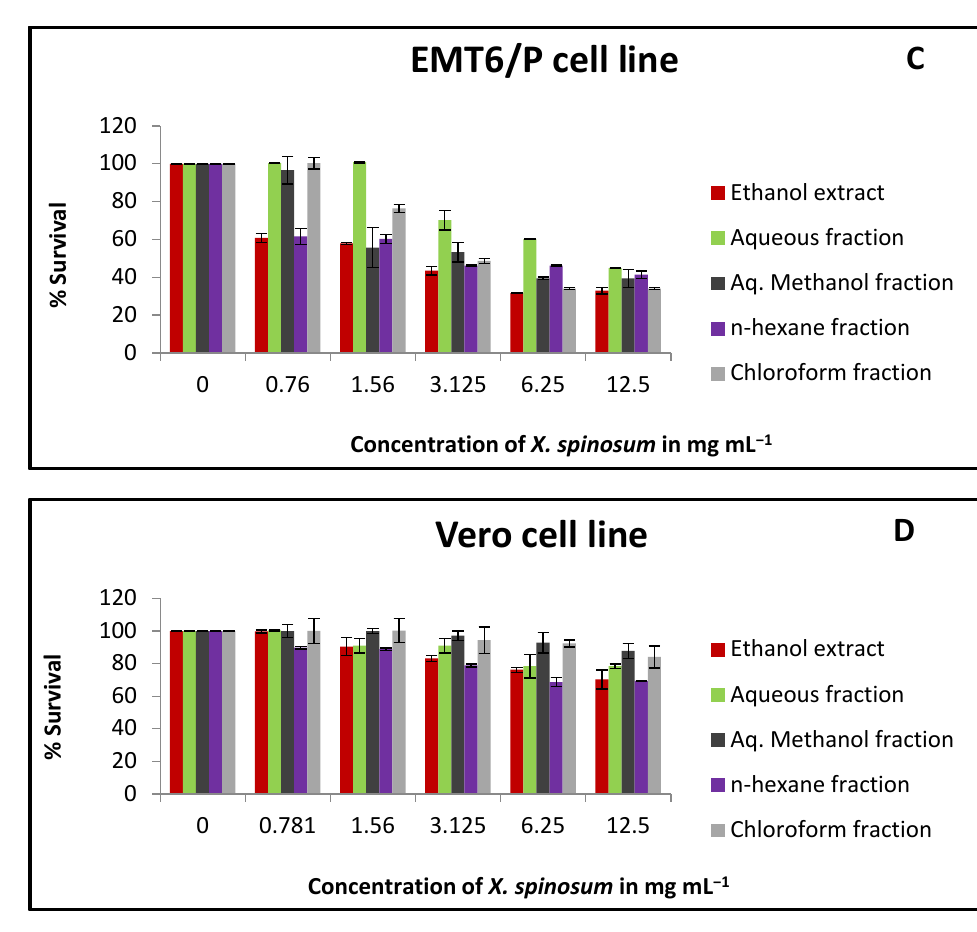
Figure 1. The antiproliferative activity of X. spinosum extract and its fractions against multiple cell lines ( A ) T47D breast cancer cells; ( B ) MCF-7 breasts cancer cells; ( C ) EMT6/P mouse breast cancer cells and ( D ) Vero normal cells. The following concentrations were used 0.78 to 12.5 mg mL − 1 . The percentage survival (%) was obtained as (OD of treated cells/OD of control cells ∗ 100). Results are expressed as means of three independent tests (bars) ± SEM (lines). Table 6. IC ₅₀ values of X. spinosum extract and fractions against different cell lines.